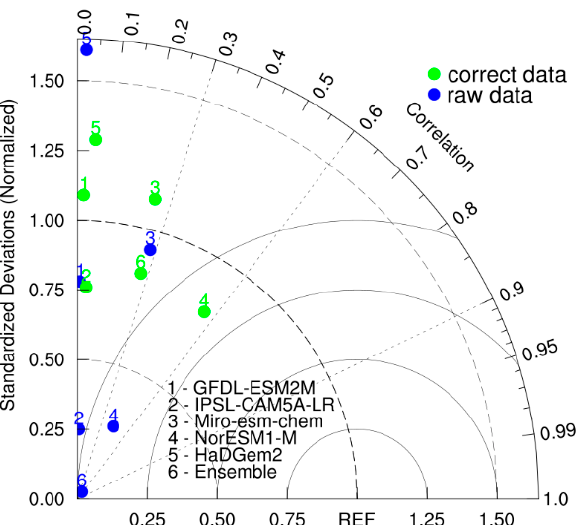
Figure 2. Taylor diagram of HSWI simulated with the 5 climate models compared with observations in the area south of the Huai River of Anhui Province from 1961 to 2005. Observation data were used as a reference. The x- and y-axes refer to the standard deviations (normalized), and the azimuthal axis refers to the time correlation between observations and model simulations.